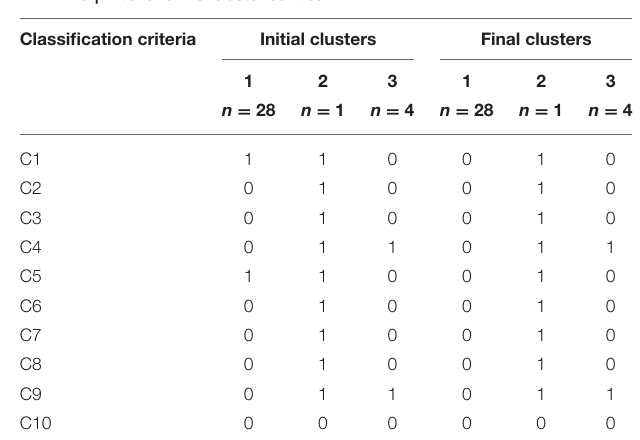
TABLE 3 | Initial and final cluster